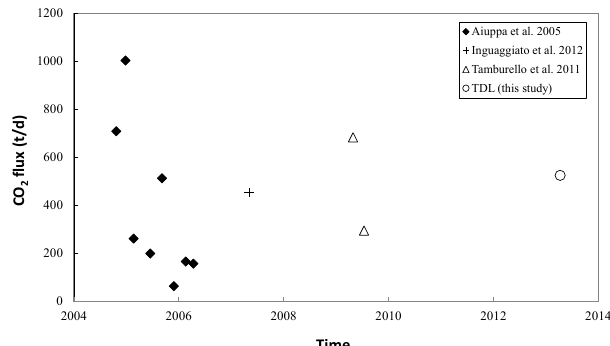
Figure 8. Time series of CO 2 flux values (td − 1 ) for La Fossa crater (Vulcano Island). Previous studies shown are: Aiuppa et al. (2005, 2006), Tamburello et al. (2011) and Inguaggiato et al. (2012). The flux value of 524 ± 108td − 1 , obtained in this study, is also